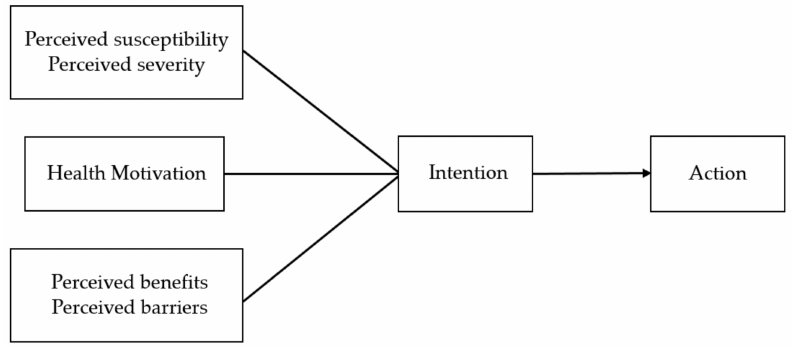
Figure 1. Framework of the Health Belief Model with integrated